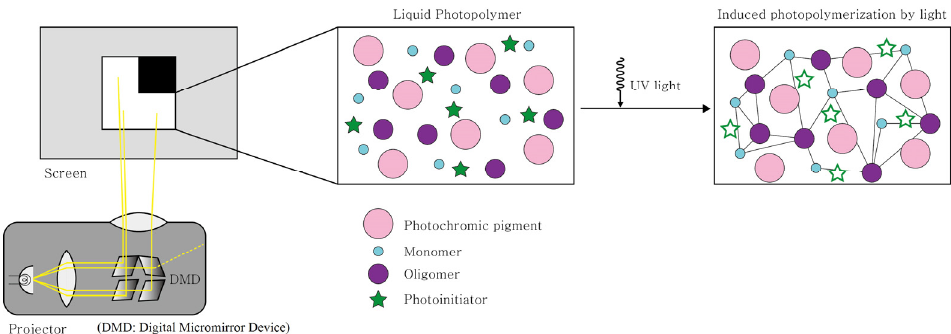
Figure 1. Photo-polymerization of resin with functional powder added.